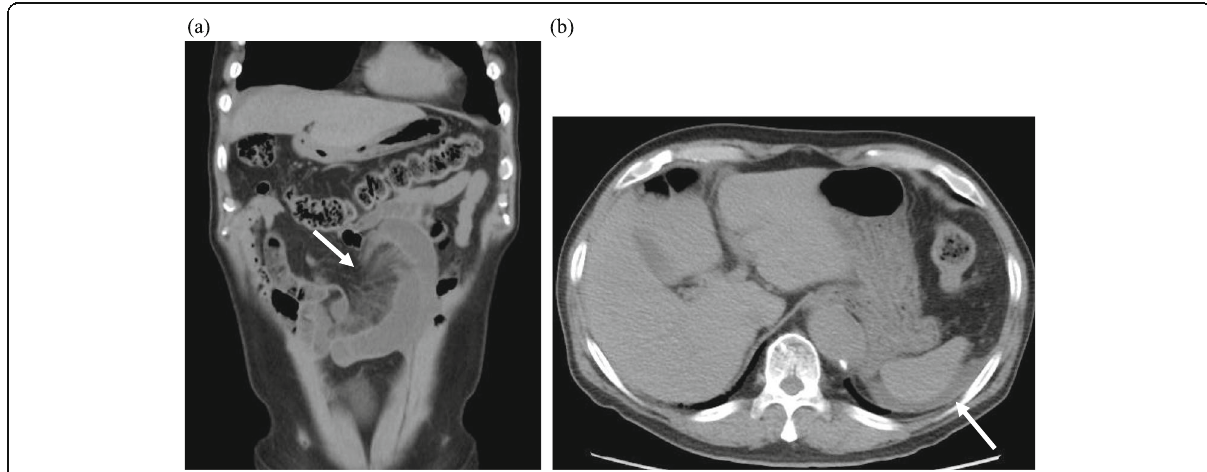
Fig. 1 Computed tomography findings. a Computed tomography revealed centralization of the mesenteric vessels and turbidity of the small intestine mesenteric fat around these vessels (arrow). These findings indicated incarceration and ischemic change of the small intestine. b The presence of fluid with high density under the diaphragm (arrow) indicated bloody